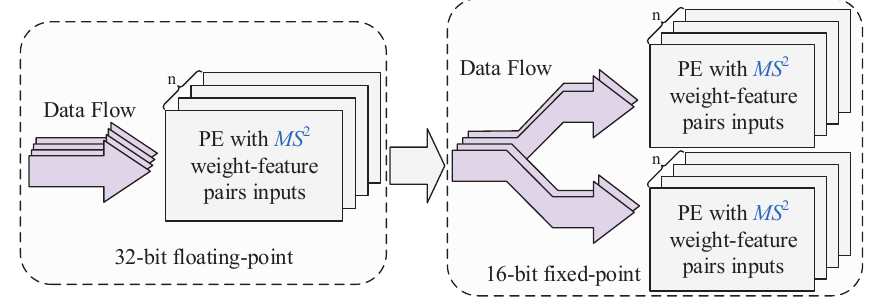
Figure 9. Parallelization-compatible processing method after data bit width is reduced.